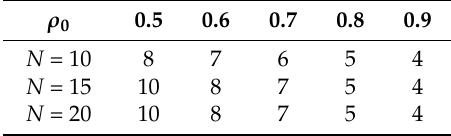
Figure 20. The relation between distortion and the number of representative nodes in the case N = 20. Table 5. Number of representative nodes with the distortion D = 0.05.